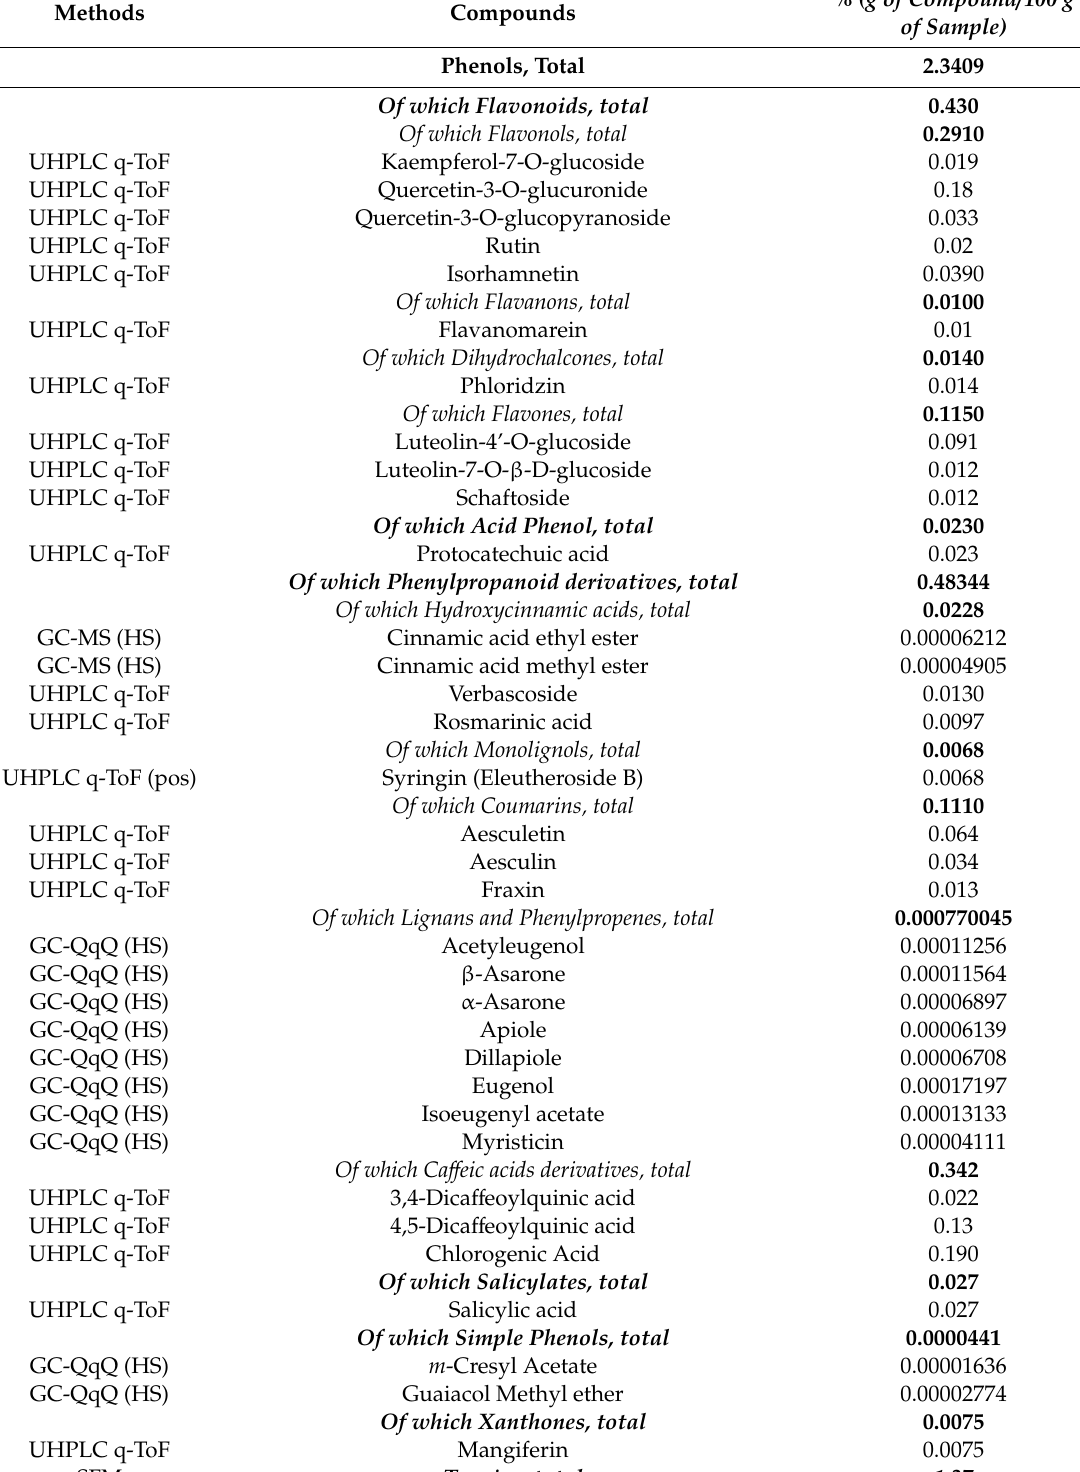
Table 1. Composition study of the system of molecules 14G1862 from Centella